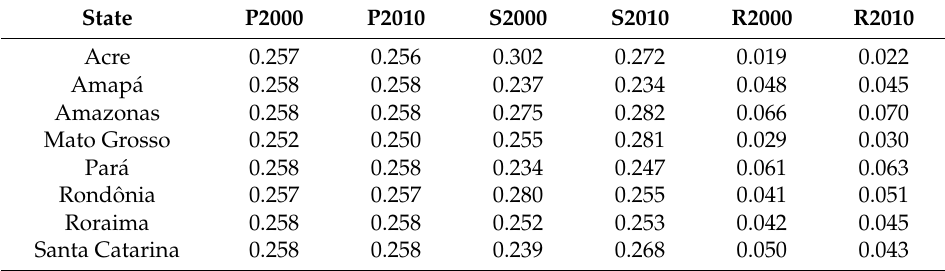
Table 6. The average PSR (pressure-state-response) value in different Amazon River Basin states. State P2000